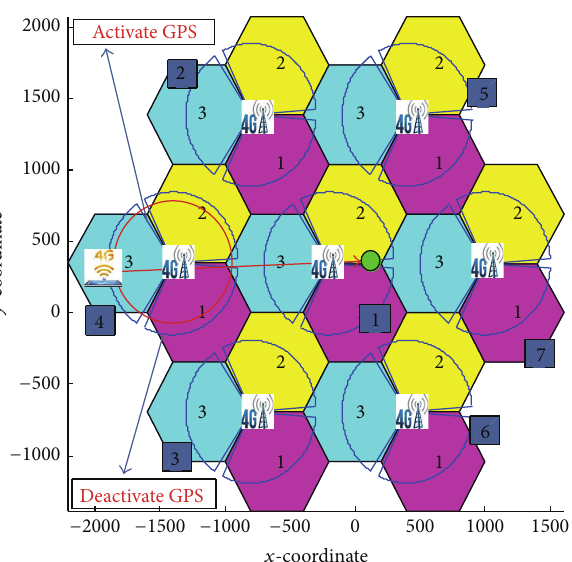
Figure 4: BS prediction using enhanced GPS prediction approach.